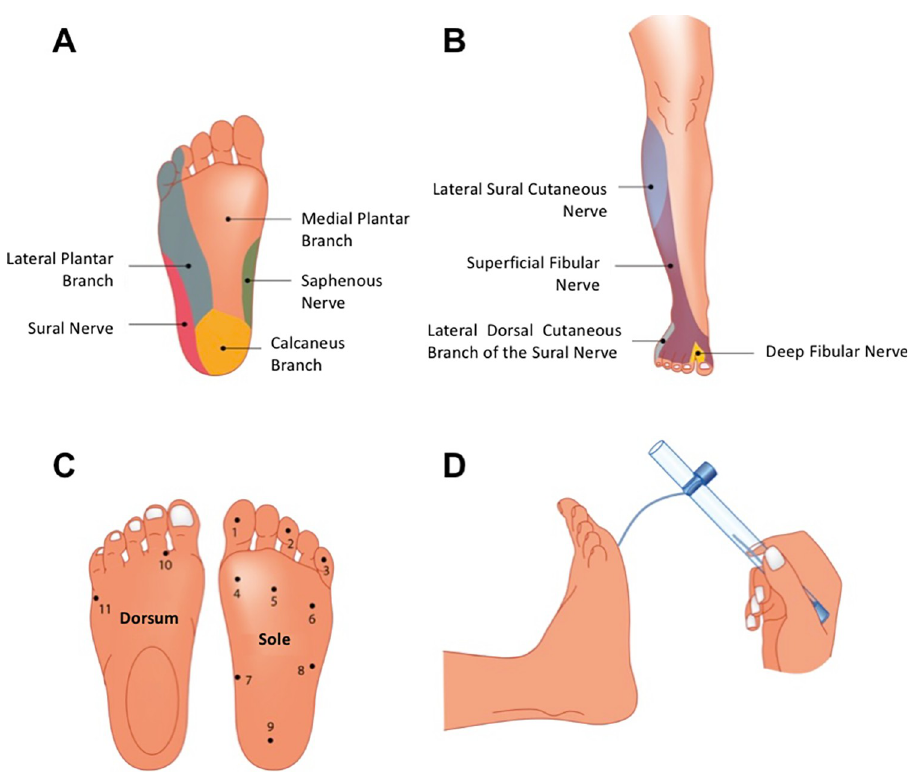
Fig 2. Dermatomes of the branches of the fibular and tibial nerves and the 11-SWM-test points tested on the foot. The normal tactile sensation threshold for the foot corresponds to the green and blue monofilaments (0.2 gf).